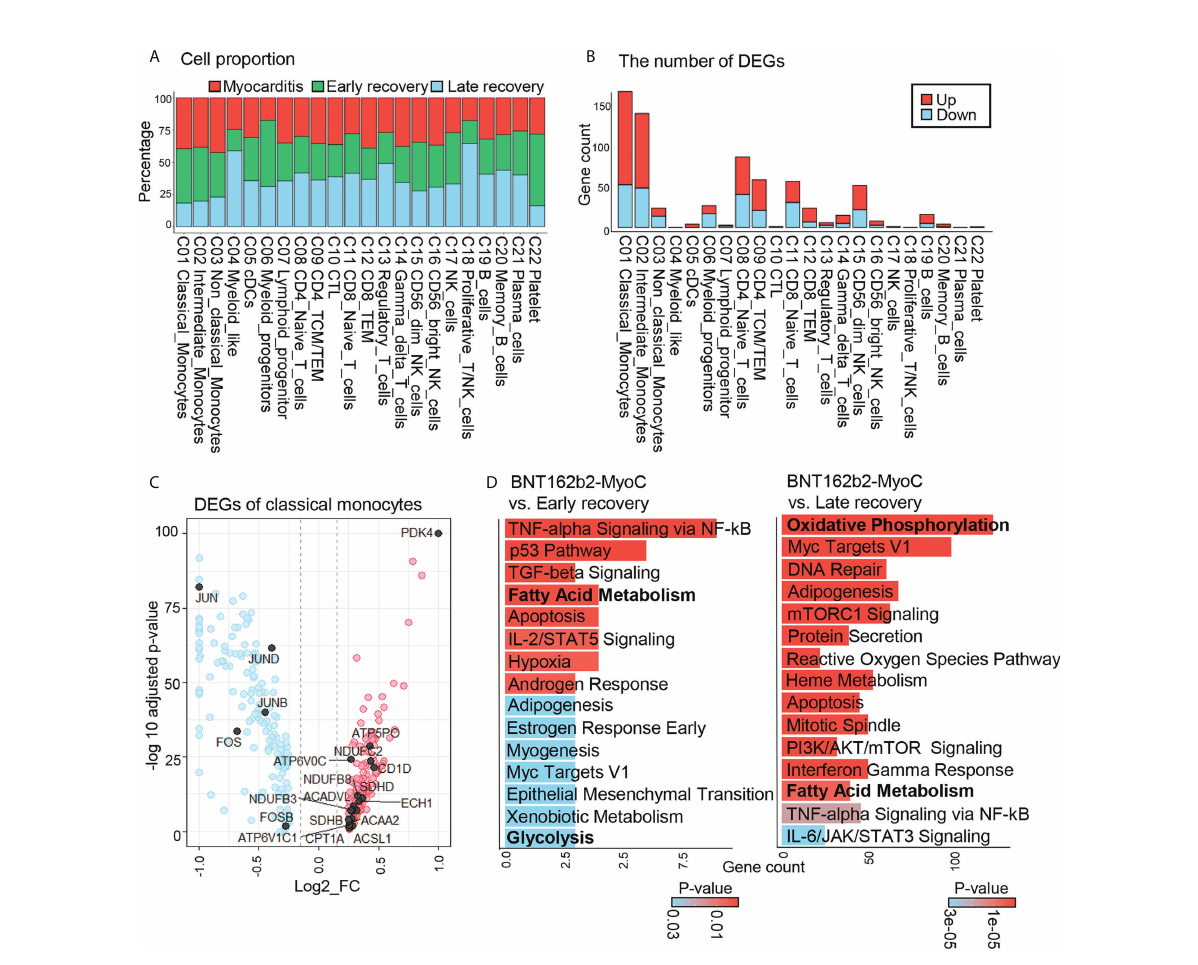
FIGURE 2 Overall Transcriptomic Pro fi les of Classical Monocytes in BNT162b2-MyoC Stage. (A) A Bar plot showing the proportion of each cell types derived from the patient in BTN162B2-MyoC, early recovery and late recovery phase, respectively. (B) Numbers of differentially expressed genes (DEGs) within each cell type in the patient in the stage of BTN162B2-MyoC compared to early recovery (p-value< 0.01, log2 fold-change (log2 FC) ≥ 0.15 or ≤ − 0.15). Down: down-regulated; Up; up-regulated. (C) Gene expression ratio (log2 FC) of classical monocytes in the patients in BTN162B2-MyoC state versus in other groups (early and late recovery state) (horizontal axis) plotted against – Log adjusted p-value (vertical axis), showing DEGs: highly expressed (red) and lowly expressed in BNT162b2-MyoC (blue). (p-value < 0.01, log2 FC ≥ 0.15 or ≤ − 0.15). (D) Gene set enrichment analysis with ‘ Enrichr ’ for up- regulated DEGs of classical monocytes in PBMCs from the patient in BNT162b2-MyoC state versus in early and late recovery stages, respectively. MSigDB_Hallmark_2020_terms are classi fi ed. P-value (color) and gene count (vertical axis) of the 20 most signi fi cant GO terms are